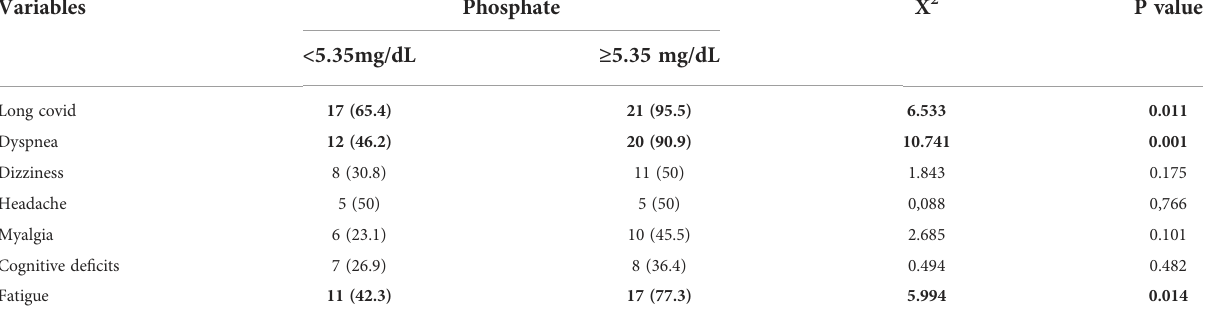
TABLE 3 Long COVID according with phosphate concentrations.